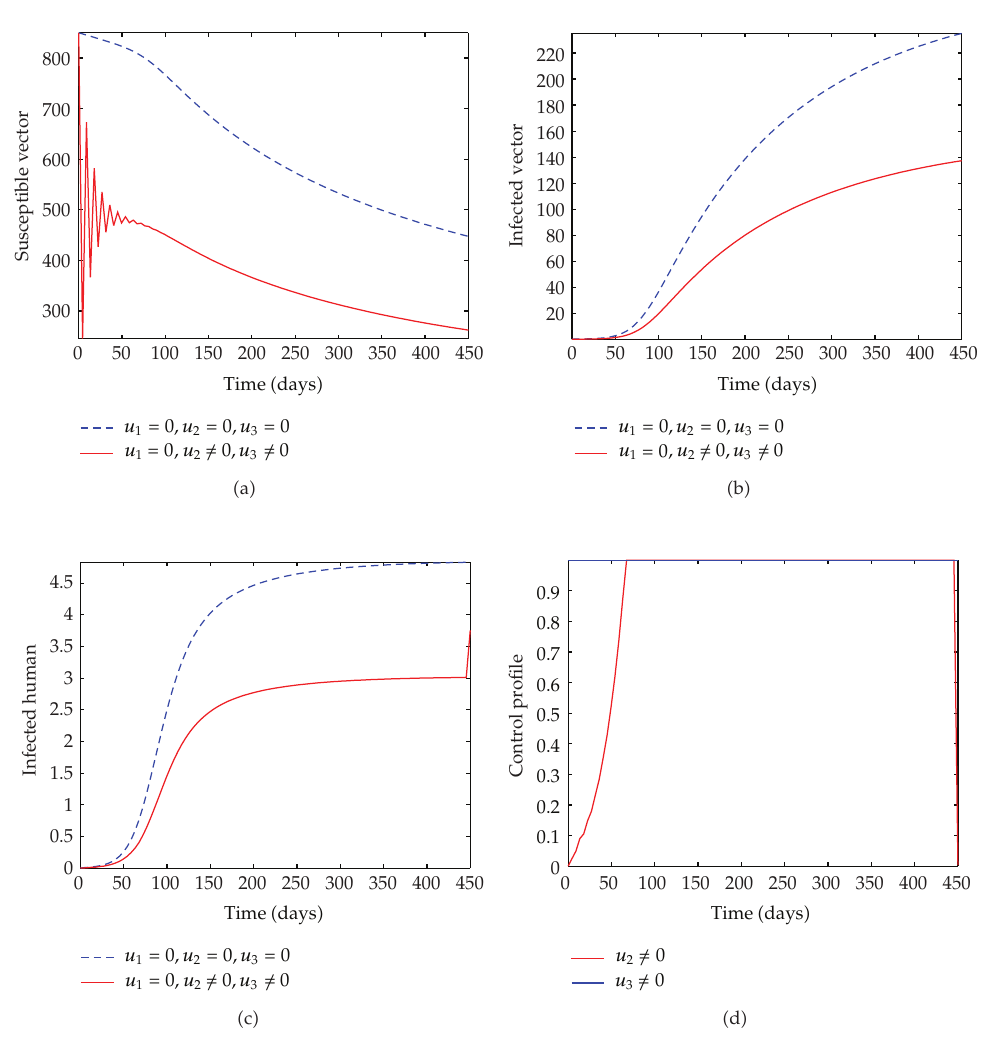
Figure 3: Simulations of the malaria model showing the e ff ect of control strategies on malaria transmission.